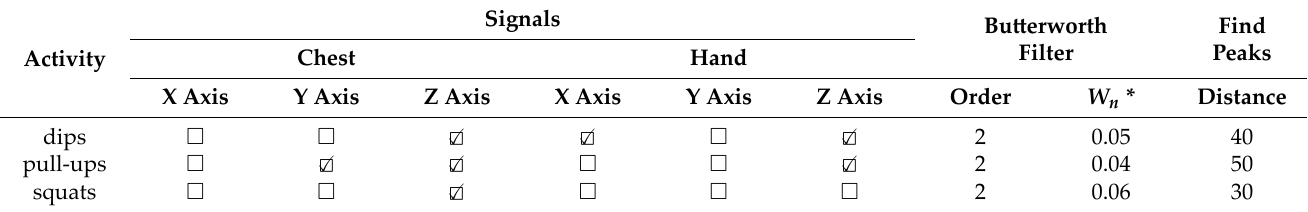
Table 10. RCM parameters.